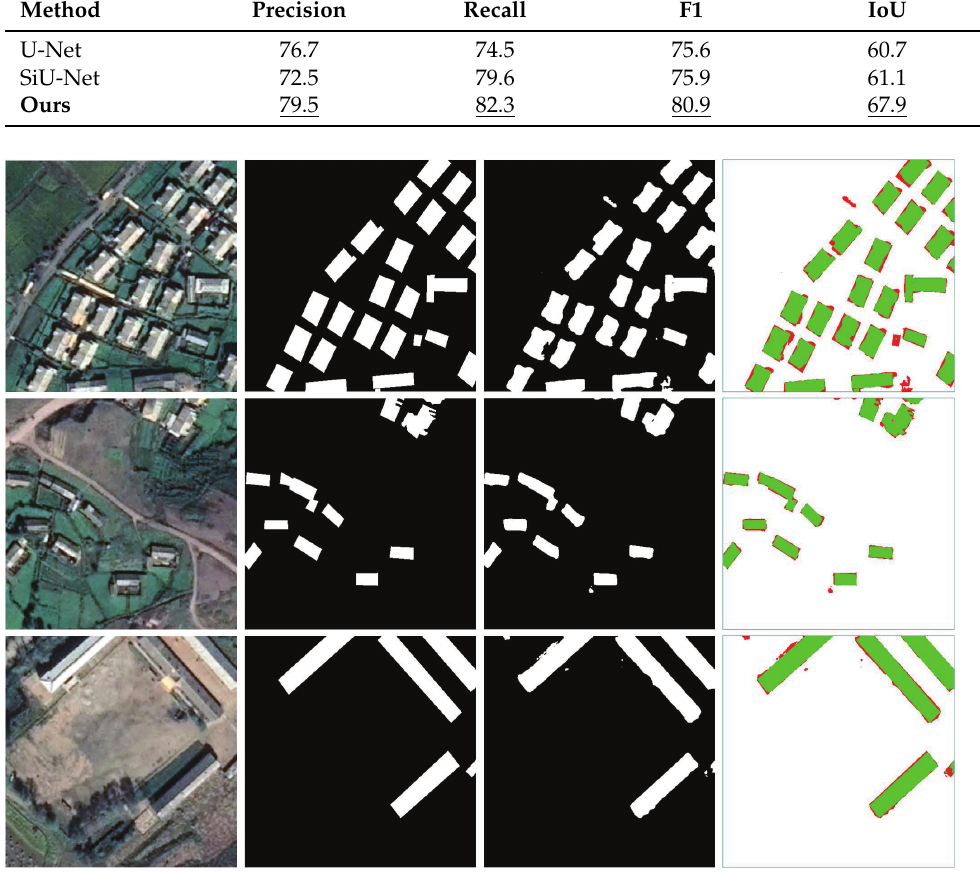
Figure 11. Examples of building extraction results on the WHU Satellite Building Dataset II. From left to right: satellite images, labels, predictions, and